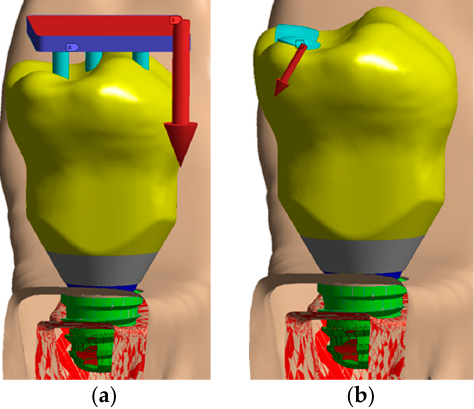
Figure 6. Loading configuration: ( a ) Axial load; ( b ) oblique load.